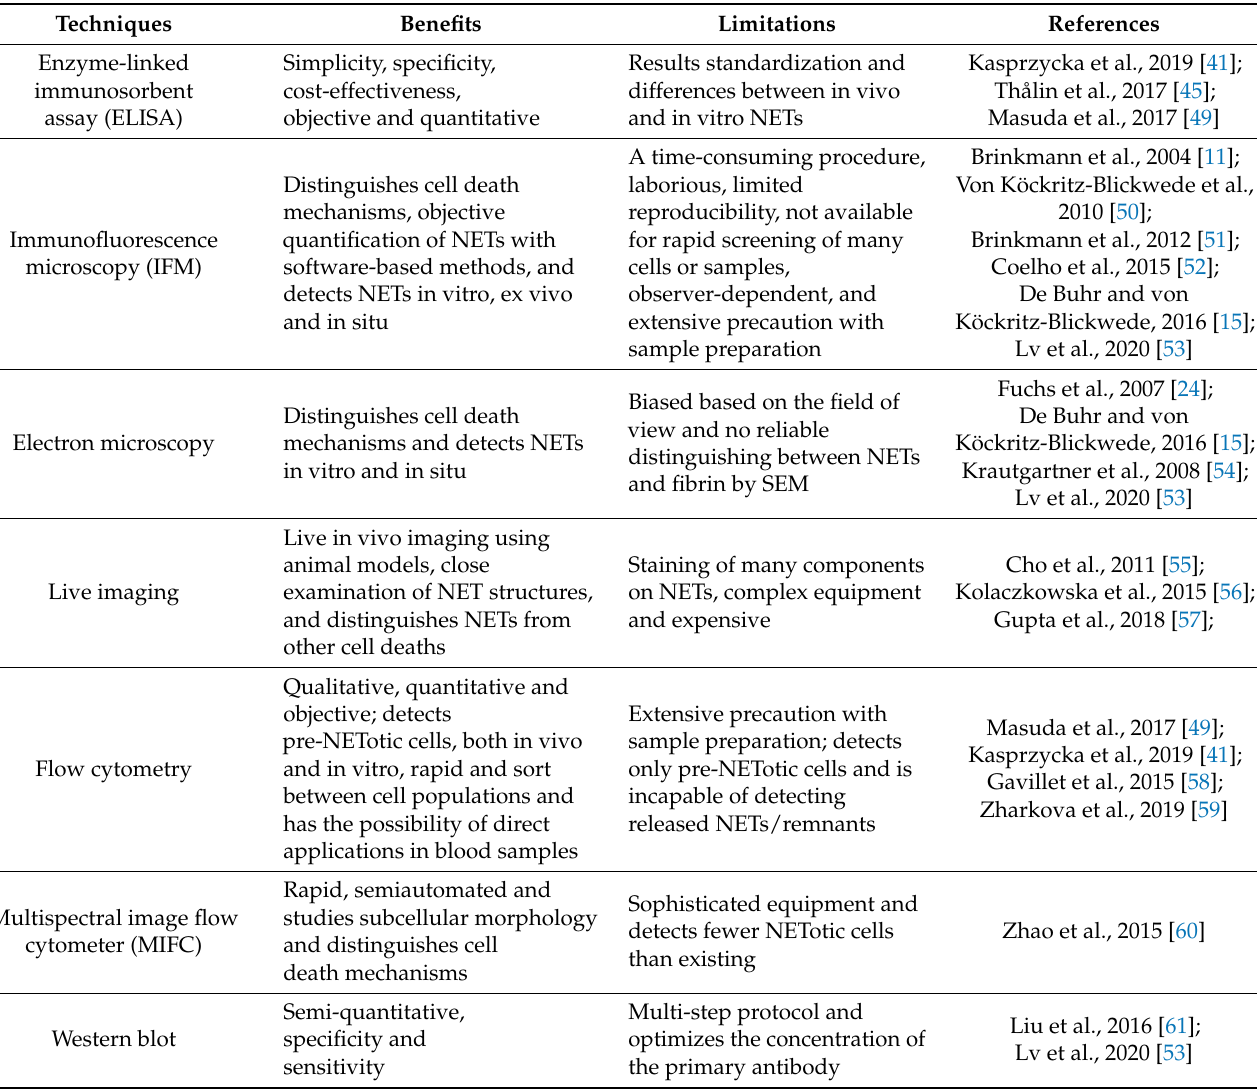
Table 1. The benefits and the limitations of each laboratory method used in the context of NET